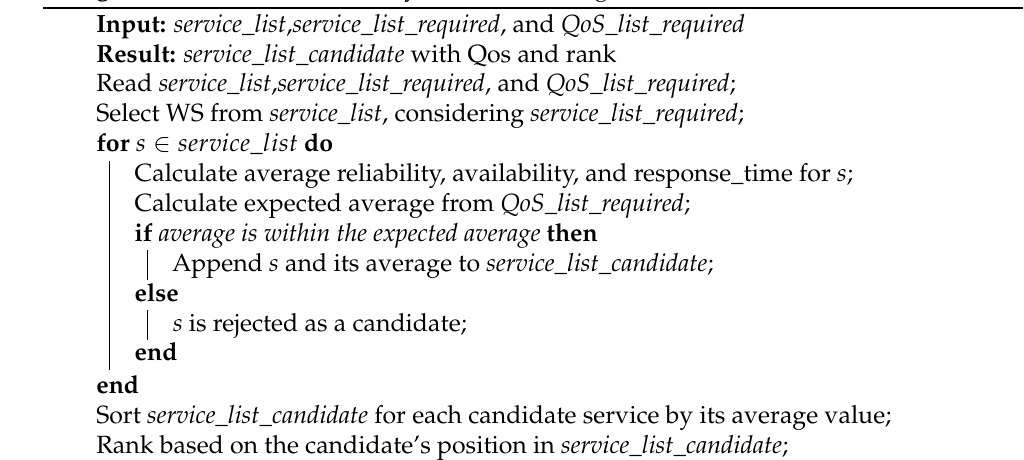
Algorithm 3: Generic discovery and selection algorithm.